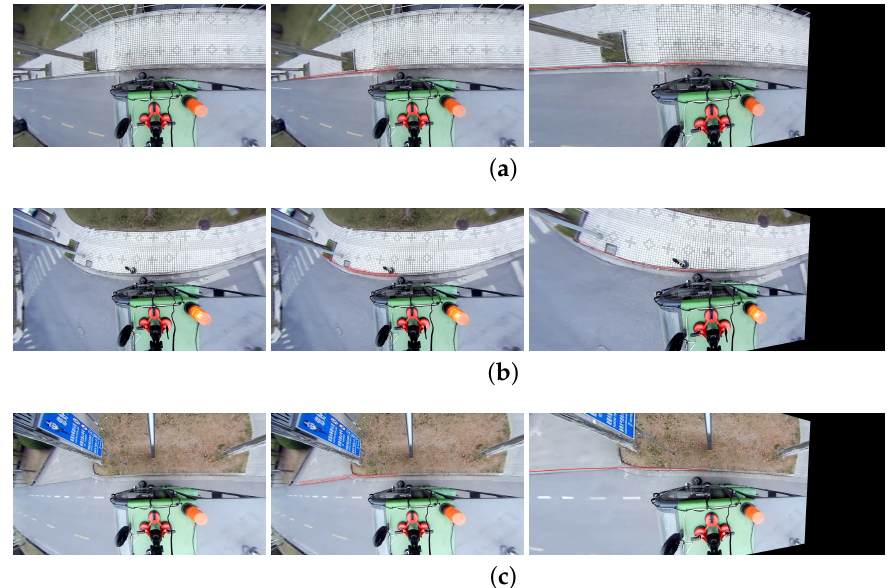
Figure 5. Experimental results of the deep curb detection network with autonomous sweeper. ( a ) curb detection results of the testing route with continuous straight curbs. Left image is a sample. Middle image shows the curb detection results which are highlighted by red color. Right image shows a fitted curve based on the curb detection results. Right image is converted into bird-view; ( b ) curb detection results of the testing route with intermittent straight curbs; ( c ) curb detection results of the testing route with winding road